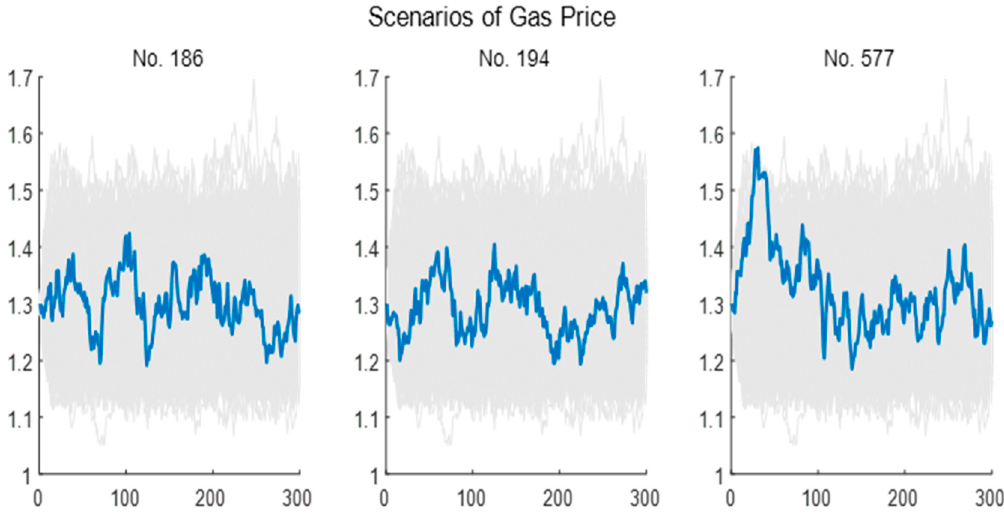
Figure 8. Constant mean value scenarios of gas prices.